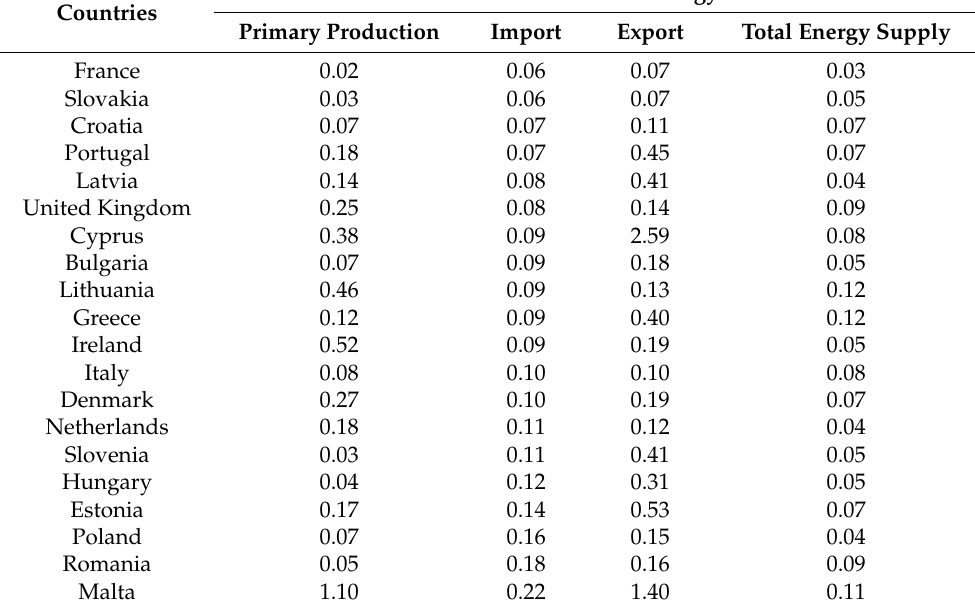
Coefficients of Variation for Energy